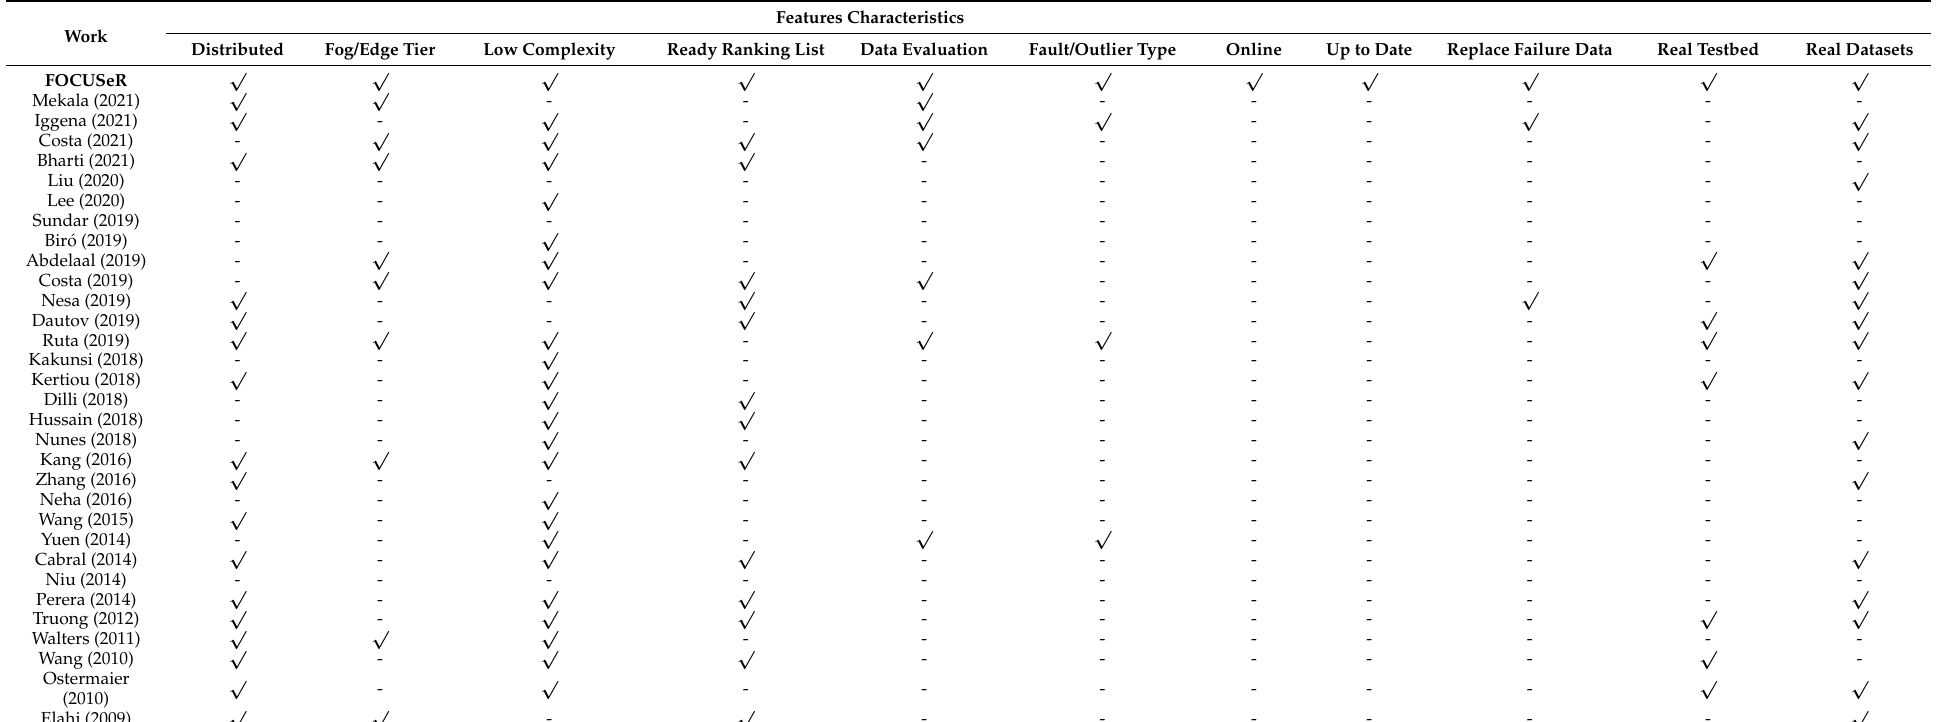
Table 2. Related